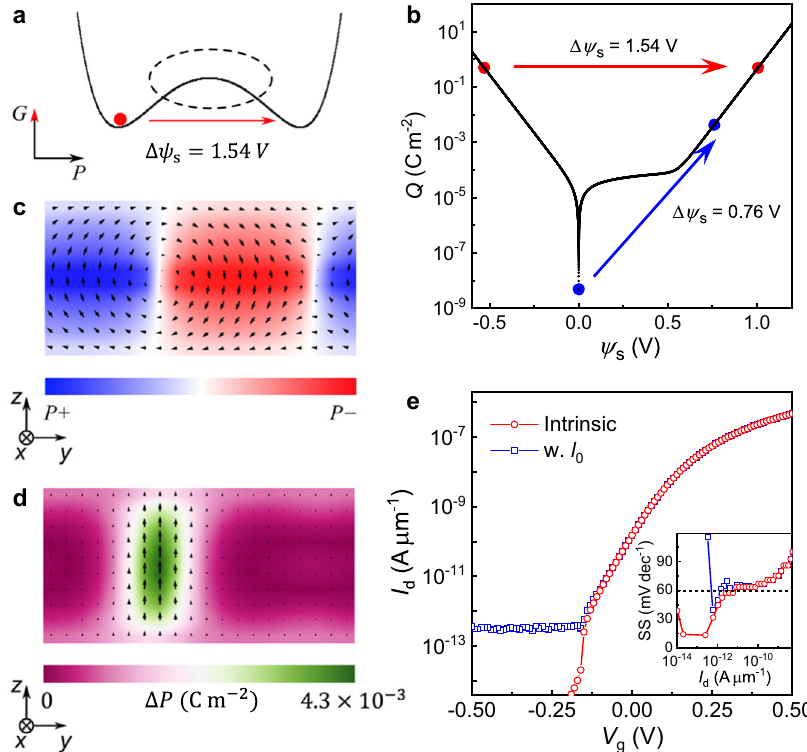
Fig. 4 3D force fi eld simulation results. a Schematic double-well Gibbs free energy pro fi le of a ferroelectric material showing the negative capacitance regime (circled). b 2D charge density Q vs. ψ s curve for MoS 2 . For a ferroelectric gate, the continuity of electric displacement yields Q ≈ P . The red arrow indicates the change of ψ s during a polarization fl ipping (from Q ¼ (cid:5) 0 : 5 C m (cid:5) 2 ; ψ s ¼ (cid:5) 0 : 53 V to Q ¼ þ 0 : 5 C m (cid:5) 2 ; ψ s ¼ 1 : 01 V ). The blue arrow indicates the change of ψ s during a polarization increase (from Q ¼ 0 C m (cid:5) 2 ; ψ s ¼ 0 V to Q ¼ þ 0 : 0043 C m (cid:5) 2 ; ψ s ¼ 0 : 76 V ). c Simulated multi-domain structure in PZT with two inequivalent DWs. The left DW hosts a polar vortex, and the right one hosts an anti-vortex. d Simulated change of polarization upon the I d jump around V g ≈ − 0.25 V. e Simulated I d vs . V g